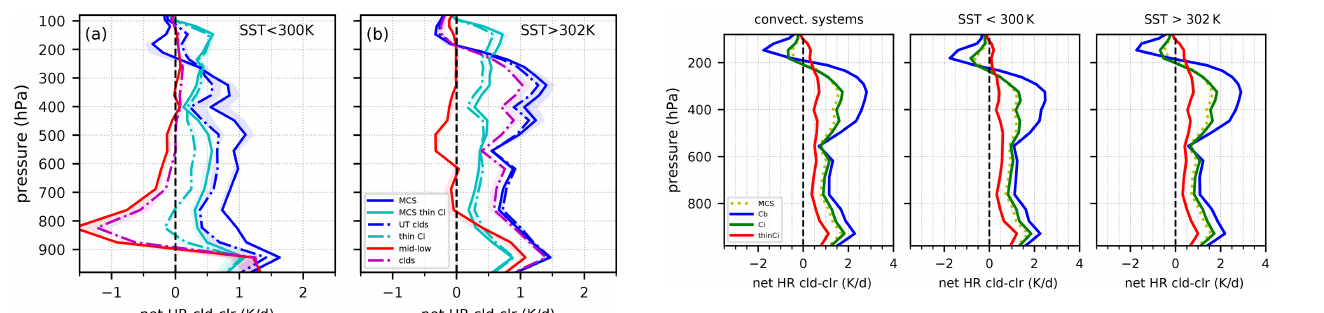
Figure 9. Mean 24h net radiative heating effect of tropical maritime MCSs, when present, and their convective cores (Cb), cirrus anvil (Ci) and surrounding thin cirrus (thinCi), separately for all MCSs (full line) and for those with single convective cores (dotted lines). Further distinguished are MCSs over the 30% coolest areas (SST < 300K) and over the 30% warmest areas (SST > 302K). Statistics of 15 years (2004–2018), averaged over 15 ◦ N to 15 ◦